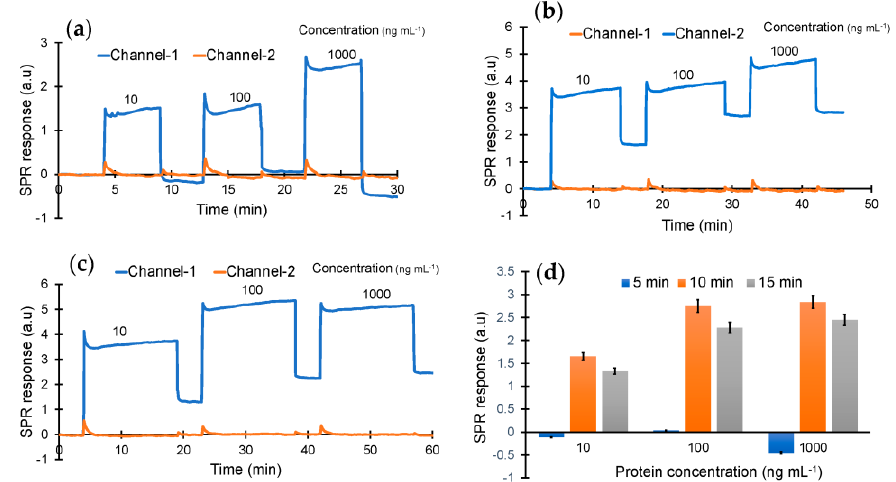
Figure 4. Real-time protein binding assay for the optimization of concentration (10, 100 and 1000 ng mL −1 ) and incubation time ( a ) 5 min, ( b ) 10 min and ( c ) 15 min. ( d ) Overall performance of the sensor with the different concentrations and incubation times.